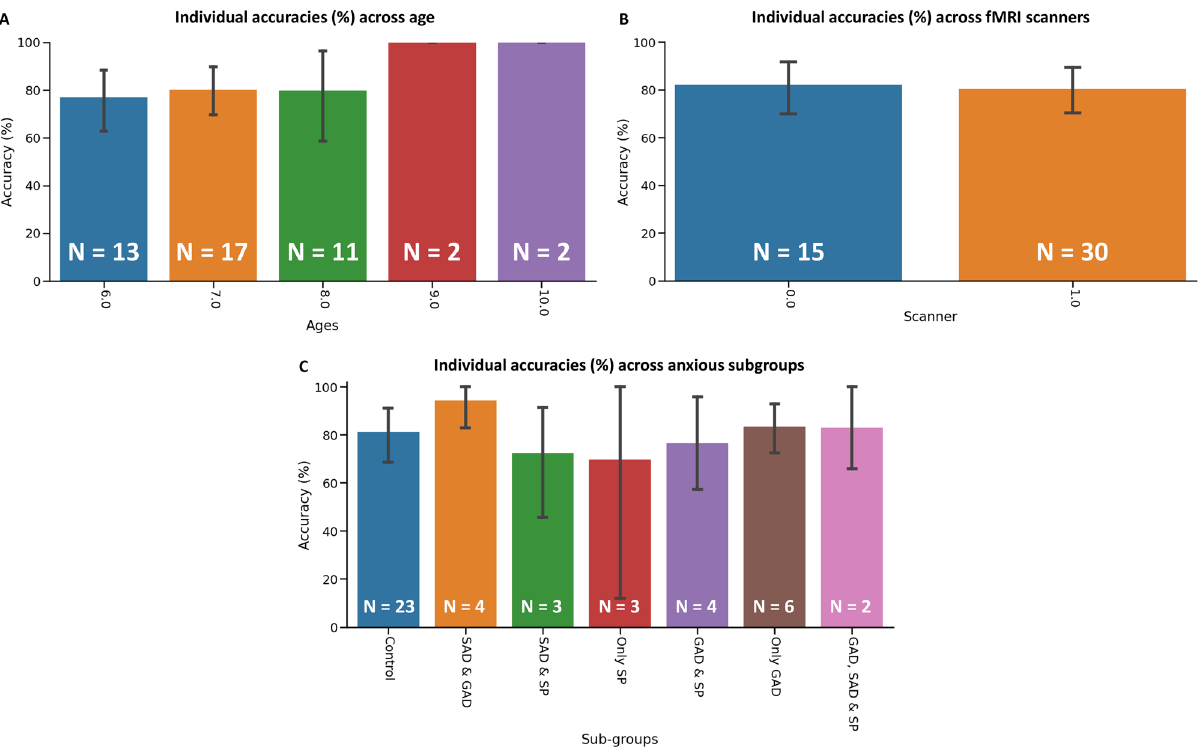
Figure 4. ( A ) Individual accuracies grouped across age (5–10) from super learner model. Mean accuracy of individuals grouped by age. ( B ) Individual accuracies grouped across fMRI scanner sites. Mean accuracy of individuals grouped by the two fMRI scanner sites. ( C ) Individual accuracies grouped by anxious subtypes. Mean accuracy of individuals with one or more comorbid anxiety diagnosis. All error bars represent the 95% confidence intervals through bootstrapping of individual accuracies.